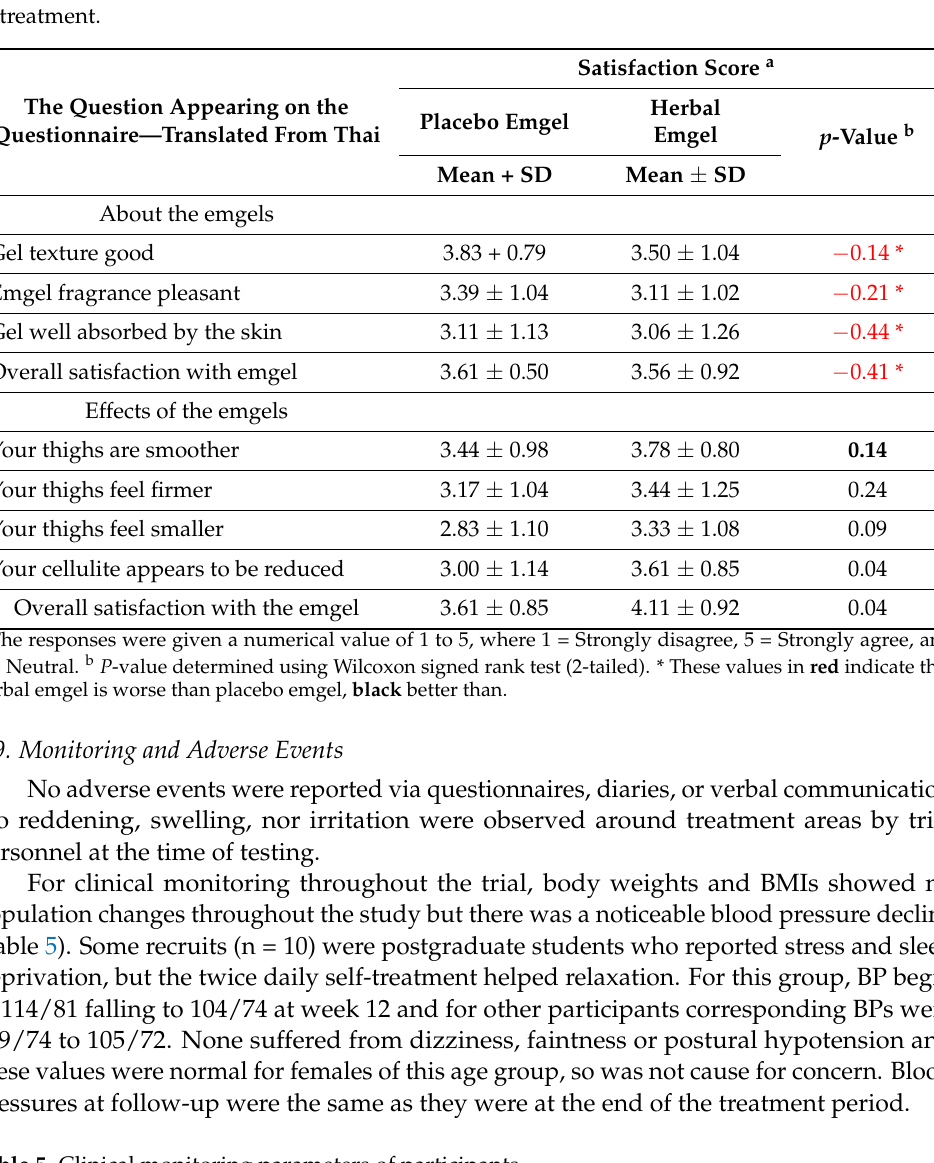
Table 5. Clinical monitoring parameters of